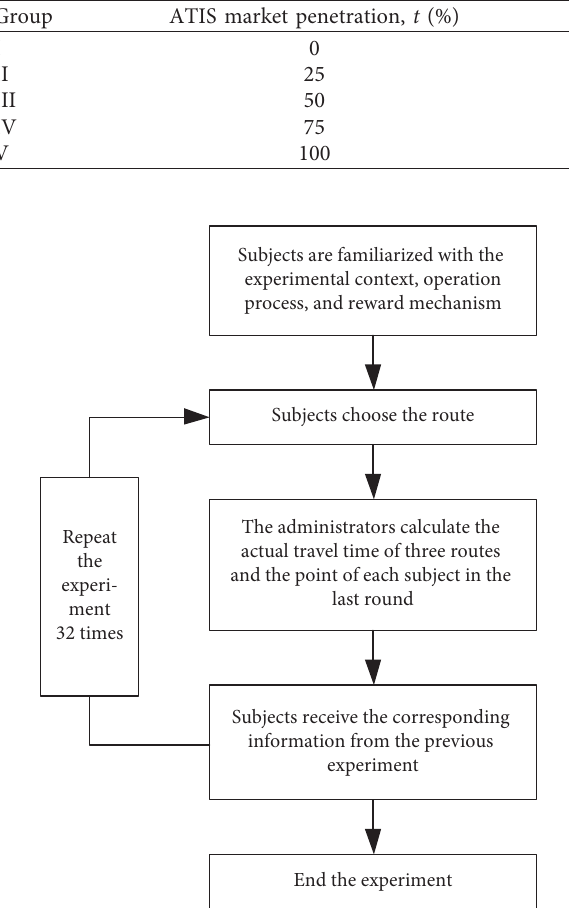
Figure 2: Tasks of experimental